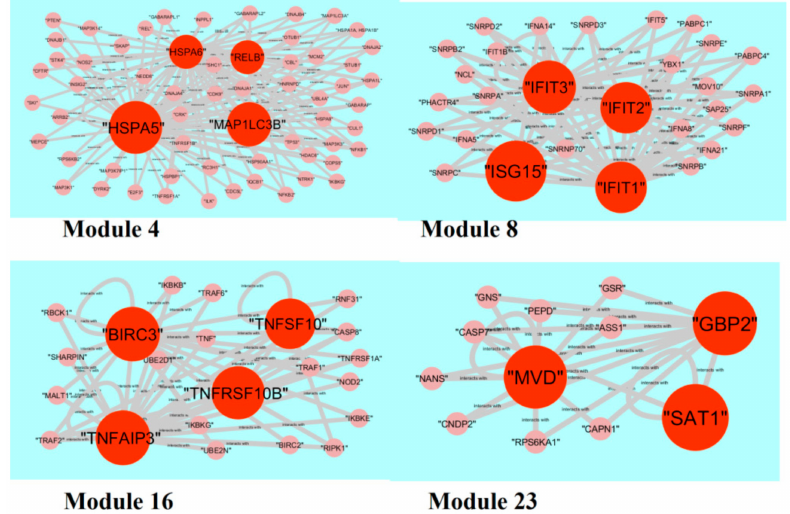
Figure 12. Modules in protein-protein interaction (PPI) network. The orange nodes denote the down-regulated